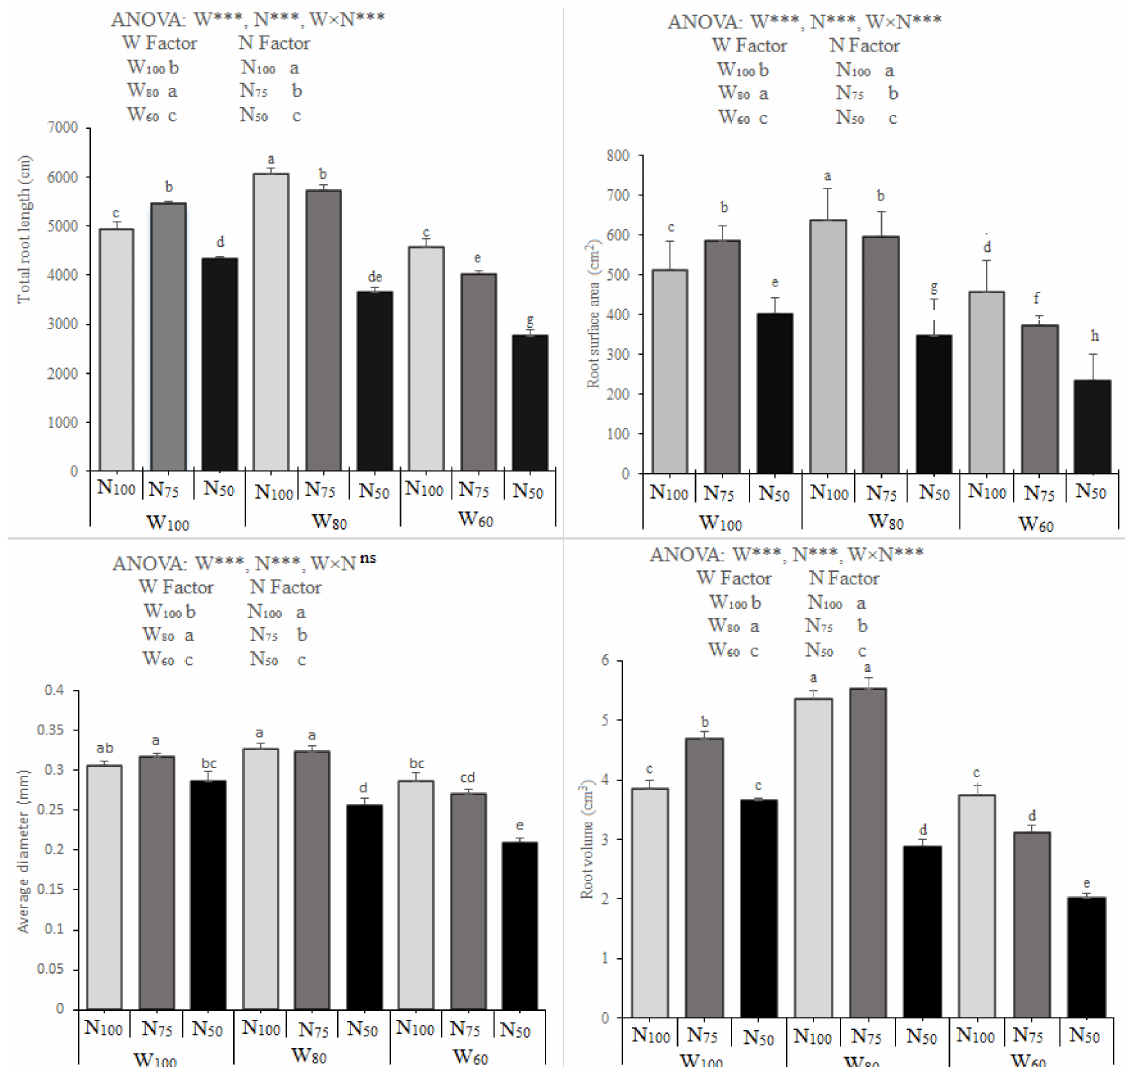
Figure 1. Effects of irrigation water (W) and nitrogen fertilization (N) on average diameter, total root length, root surface area, and root volume at the harvesting stage during spring–summer. Bars with different letters are significantly different at p < 0.05 according to LSD test. ns, *** are not significant at p > 0.05, significant at p ≤ 0.001,